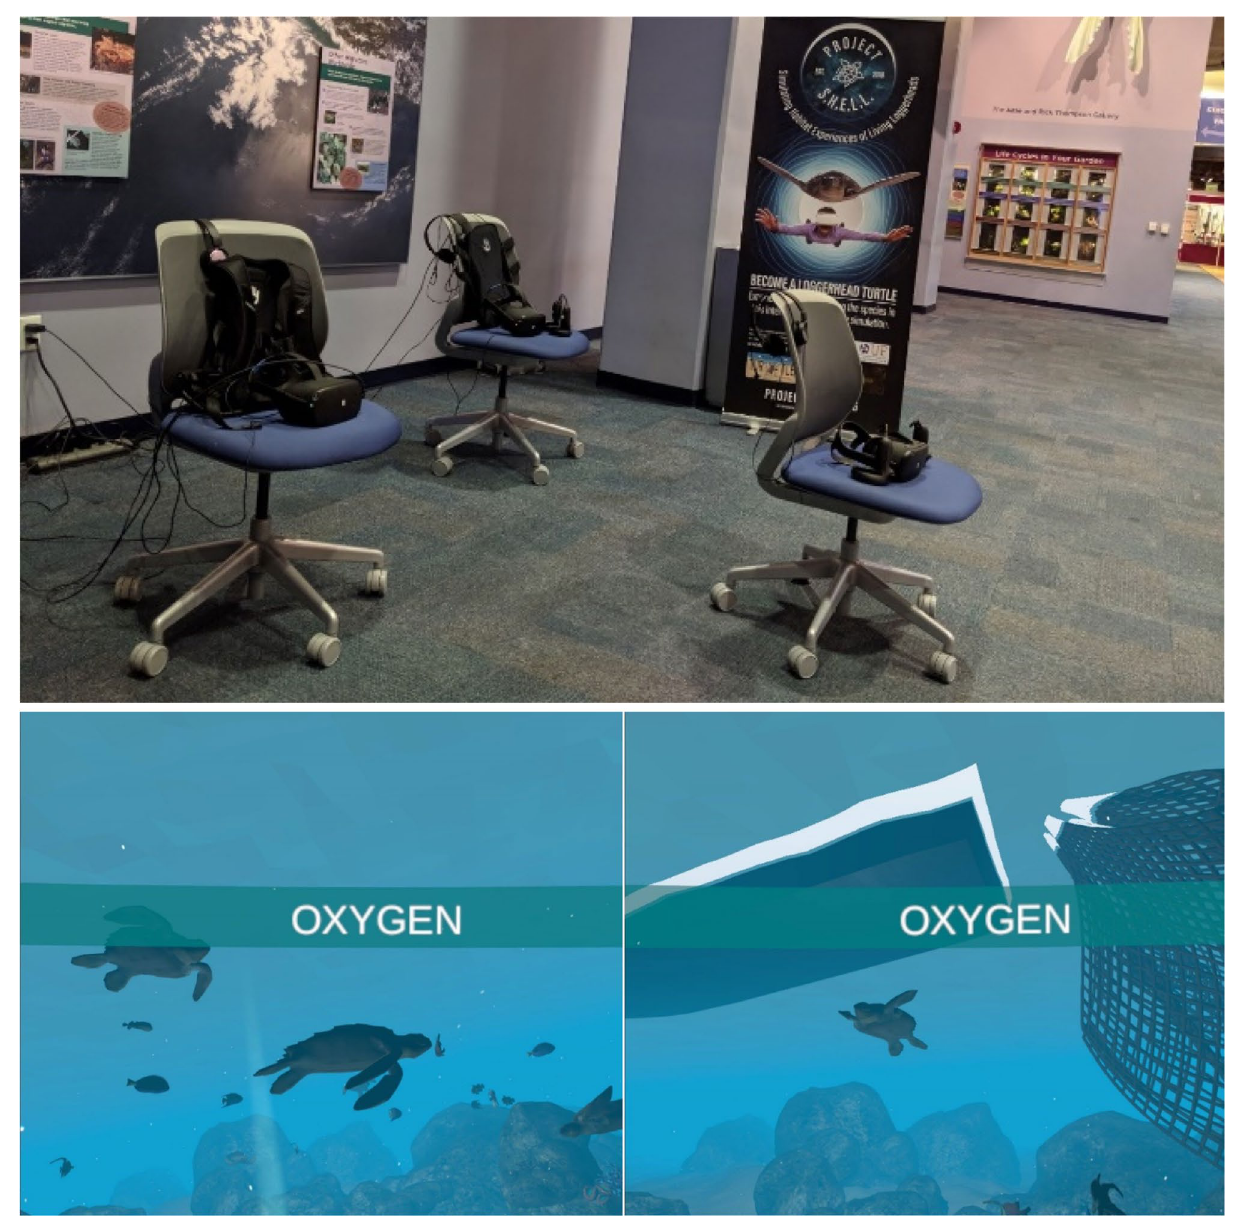
Figure 5. Experimental set-up and stimuli used in Study 3. Field study participants were randomly assigned to one of three VR stations (top), each representing one of three experimental conditions. In-game screenshots demonstrate the salience of victim count (seven: bottom left), and of particular environmental threats, such as getting caught in fishing netting (bottom